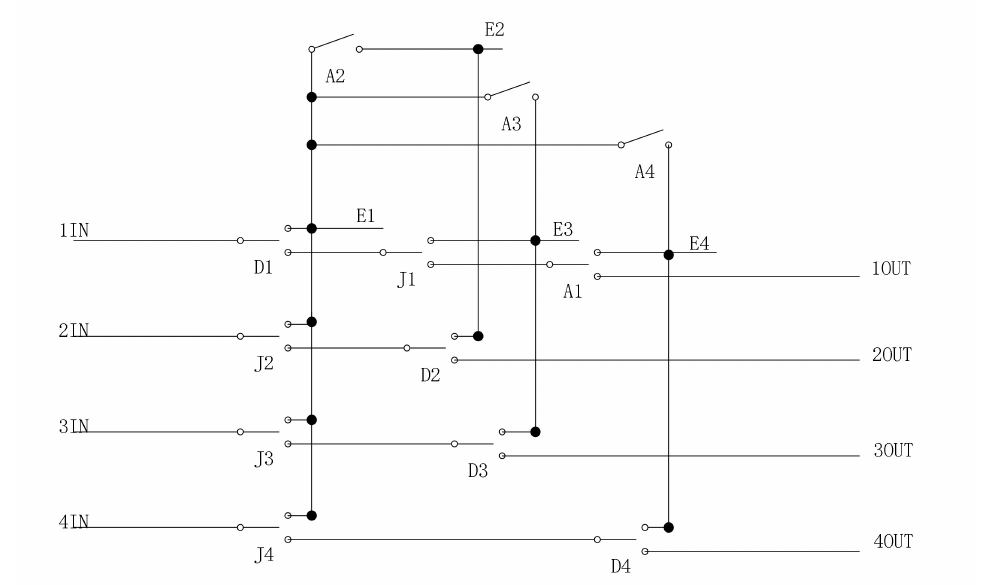
Figure 8. Schematic diagram of I/O ports and electrode connections with the distributed